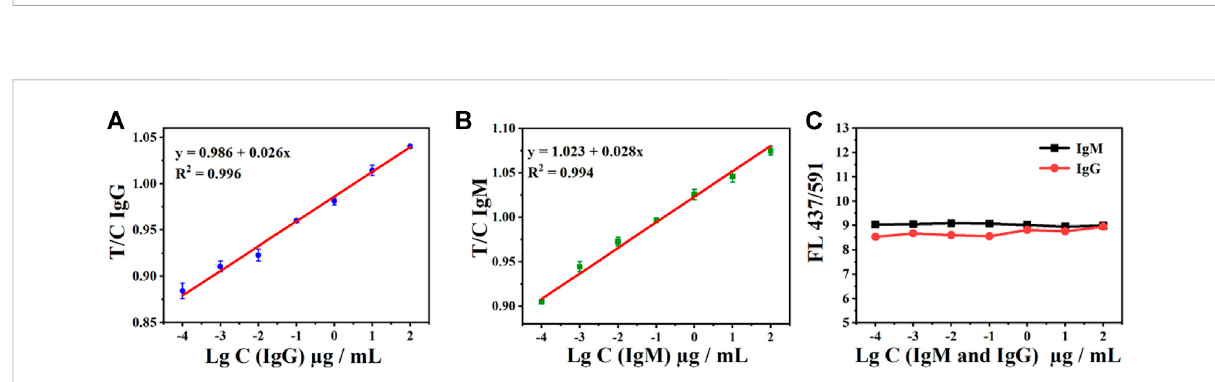
FIGURE 5 Ratio of T-line to C-line (T/C) under the excitation at 365 nm and the gradient concentration detection of (A) IgG and (B) IgM antibodies; (C) AIE-CD-SSP for the detection of gradient concentrations of IgM and IgG antibodies under the excitation at 365 nm and the ratio of emission fl uorescence intensity at 437 nm and 591 nm FL (437/591)